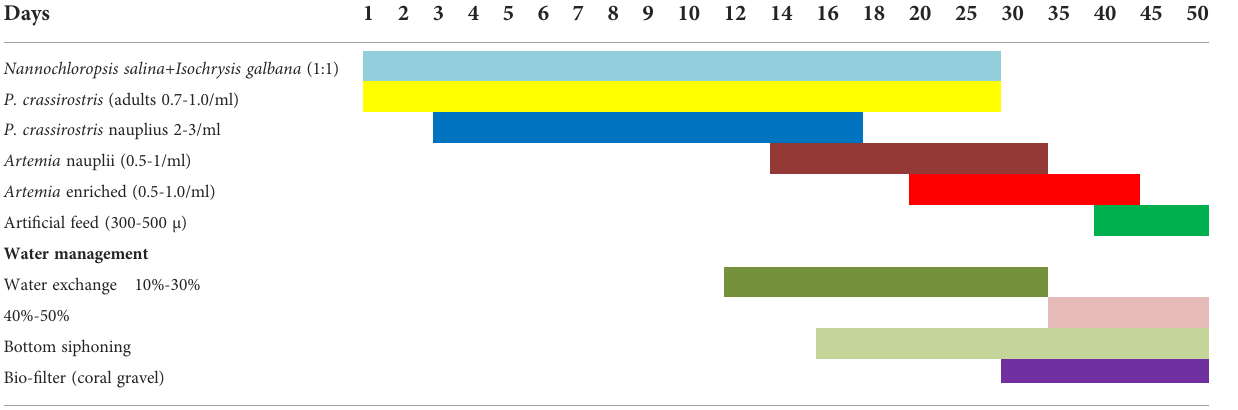
TABLE 7 Feeding and water management schedule of Anthid fi shes. Days